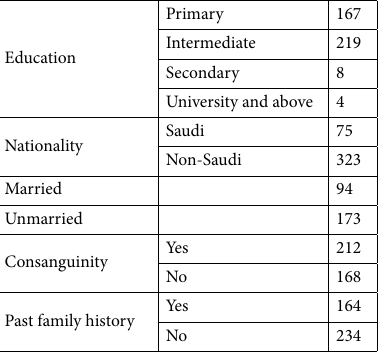
Table 2. Frequency IDA based on sociodemographic factors.